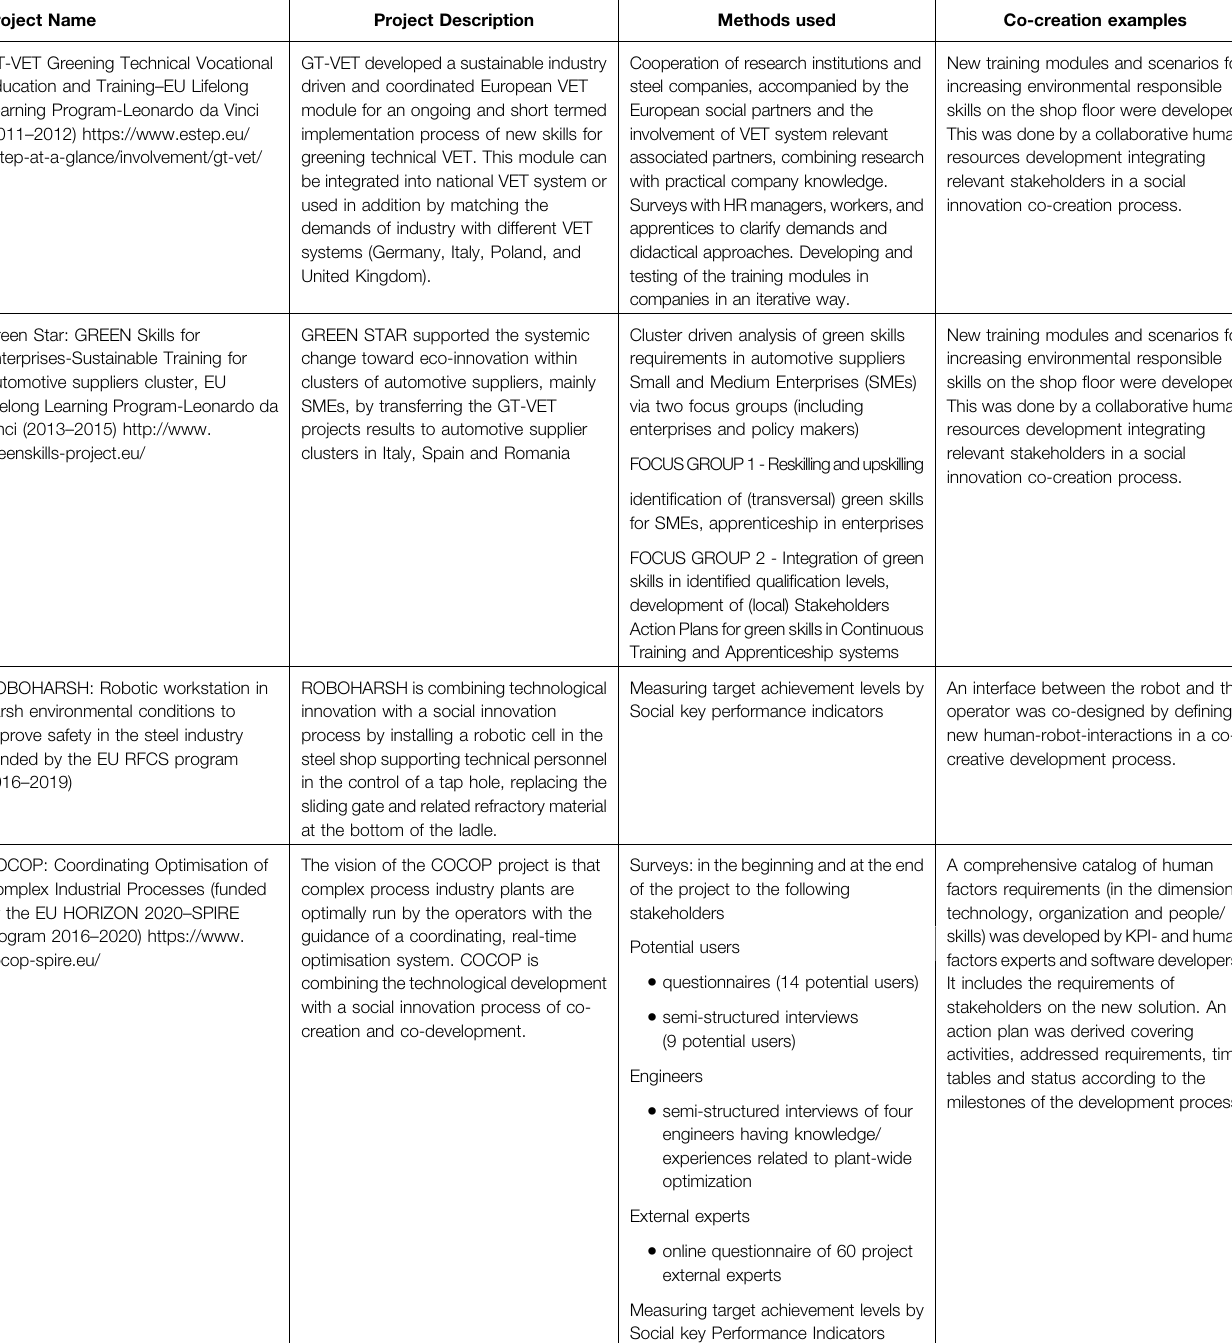
TABLE 1 | Summary of analyzed projects and co-creation practices. Source: self-elaborated based on the projects GT-VET, Green Star, COCOP and